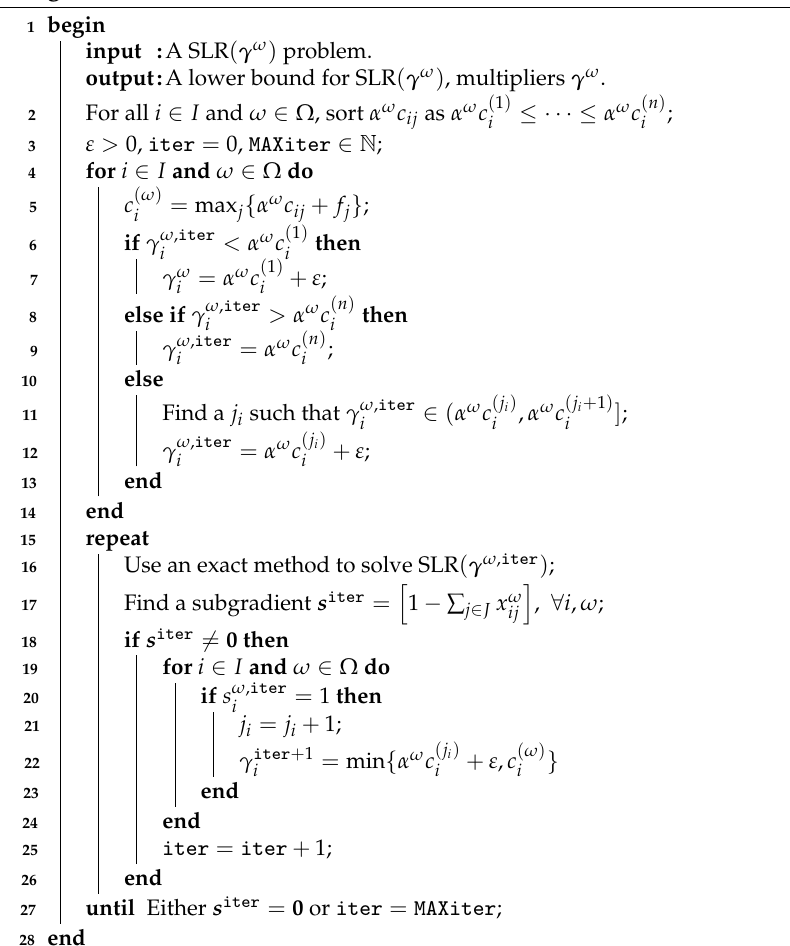
Algorithm 3: Dual ascent method.